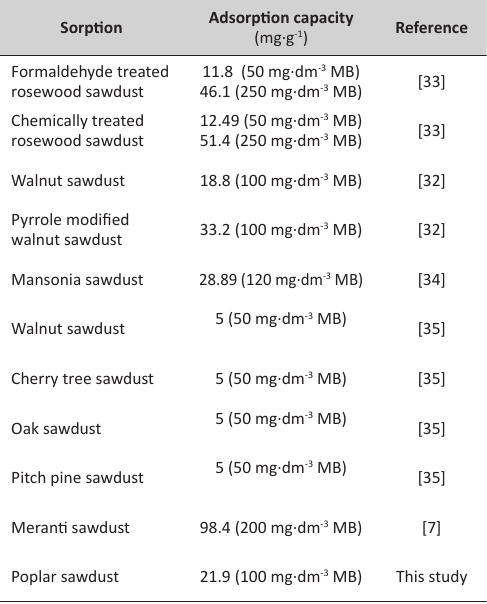
=50 mg·dm -3 , dye tABle 2. Comparison of experimentally obtained adsorption capacities of various biosorbents for